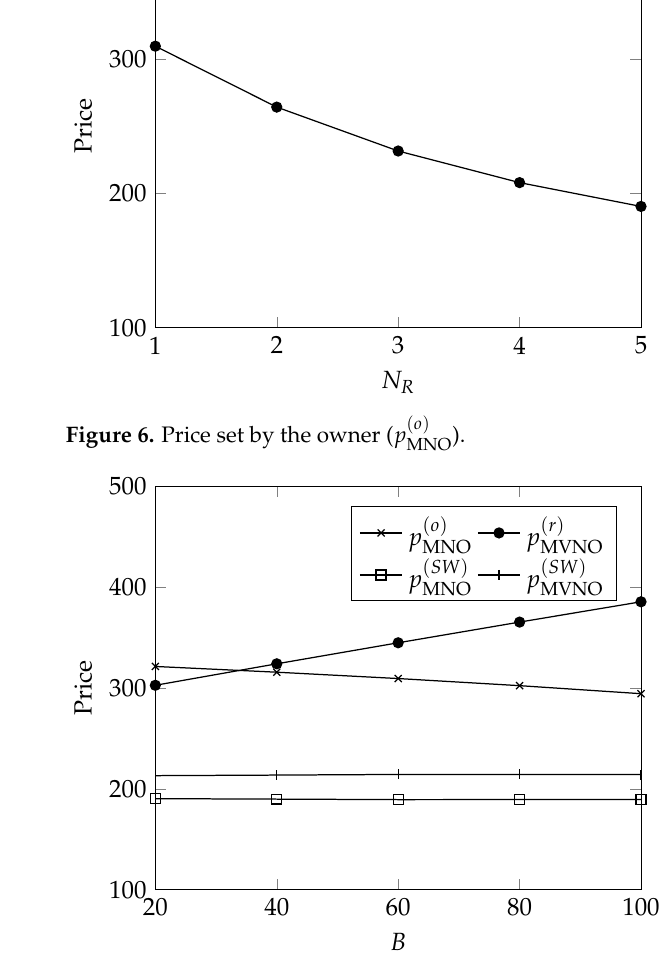
Figure 7. Impact of bandwidth on prices with a single renter.